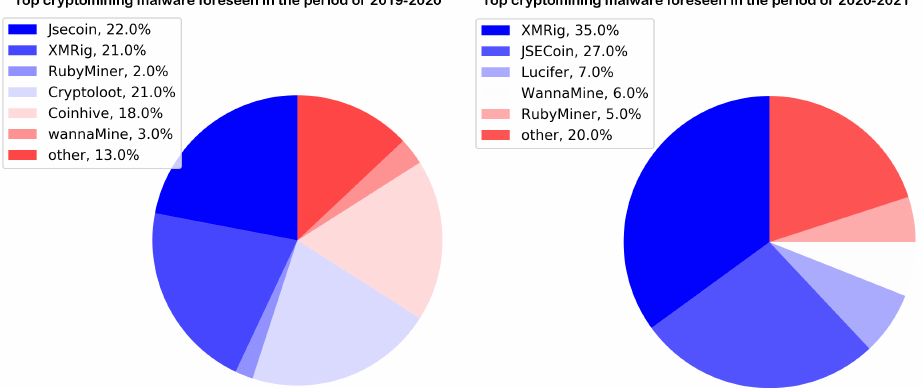
Figure 1. On the authority of ENISA and the Internet Organised Crime Threat Assessment (IOCTA), a list of illegal cryptocurrency abuse platforms is presented, as part of the most frequent and harmful threats since 2019